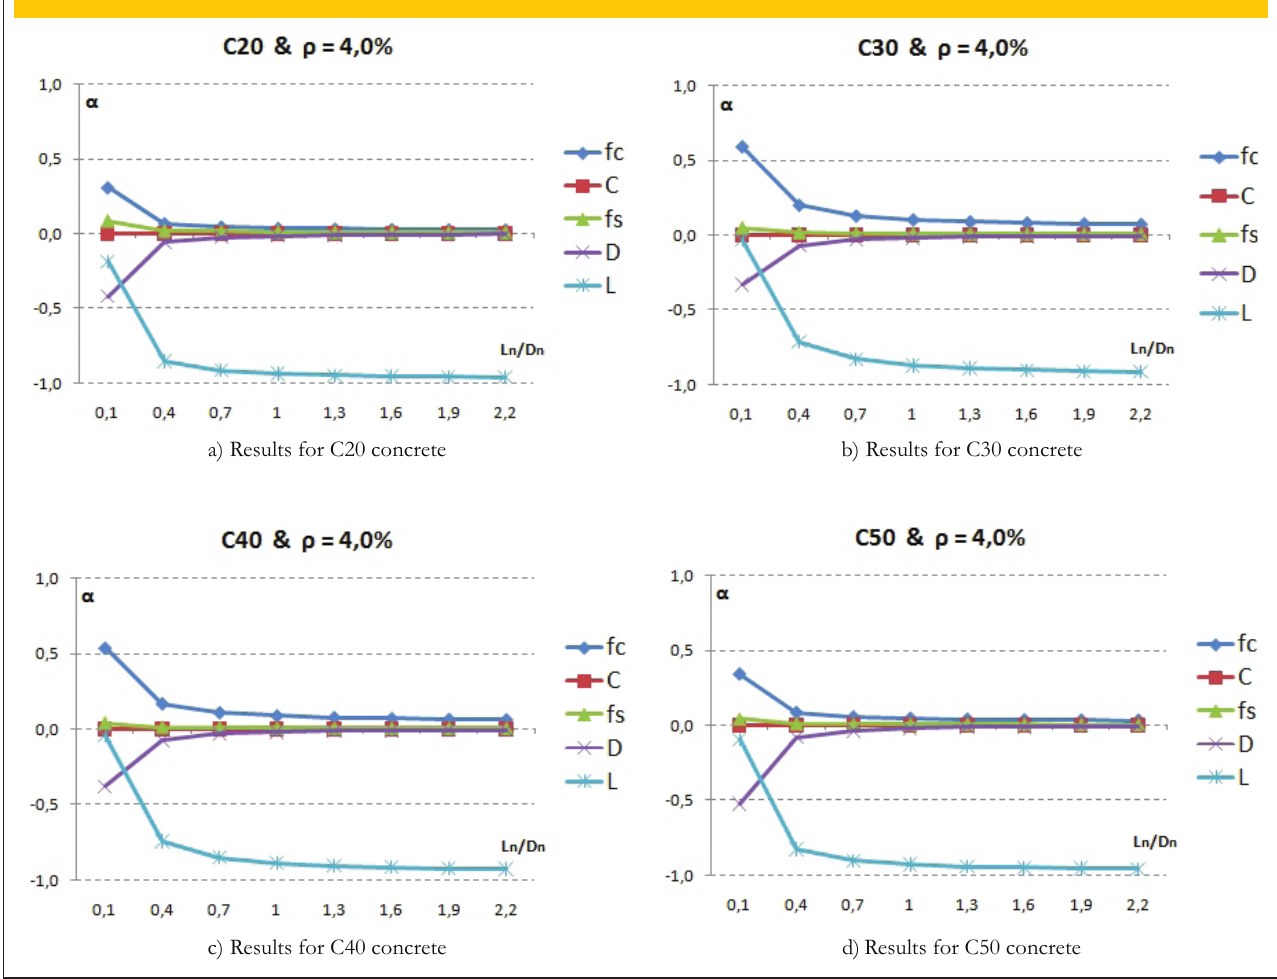
d) Results for C50 concretec) Results for C40 concrete